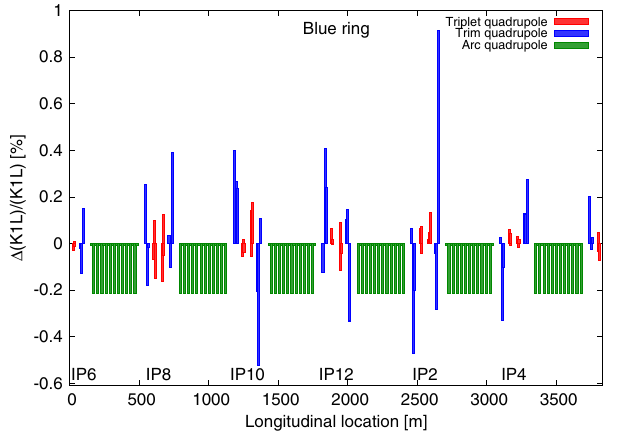
FIG. 4. Baseline and corrected horizontal (bottom) and vertical (top) beta-beat with error bars for the Blue ring. Horizontal peak beta-beat was corrected from 15% to 8%, while vertical peak beta-beat from 40% to 14%.